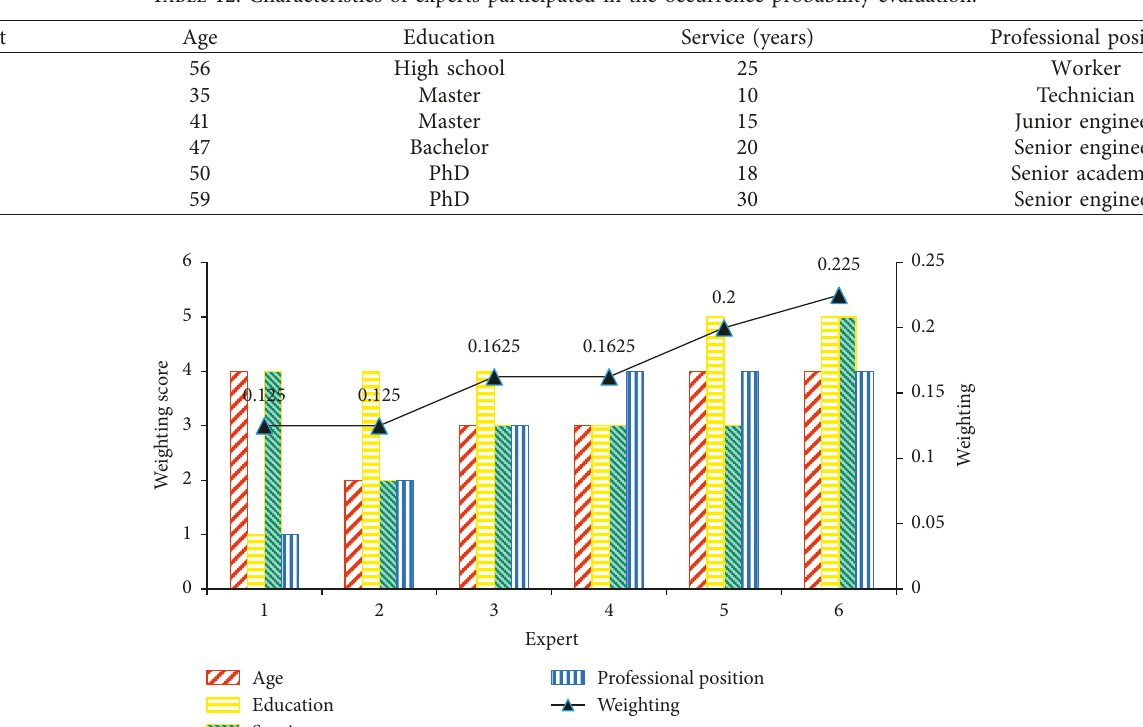
Table 12: Characteristics of experts participated in the occurrence probability evaluation.